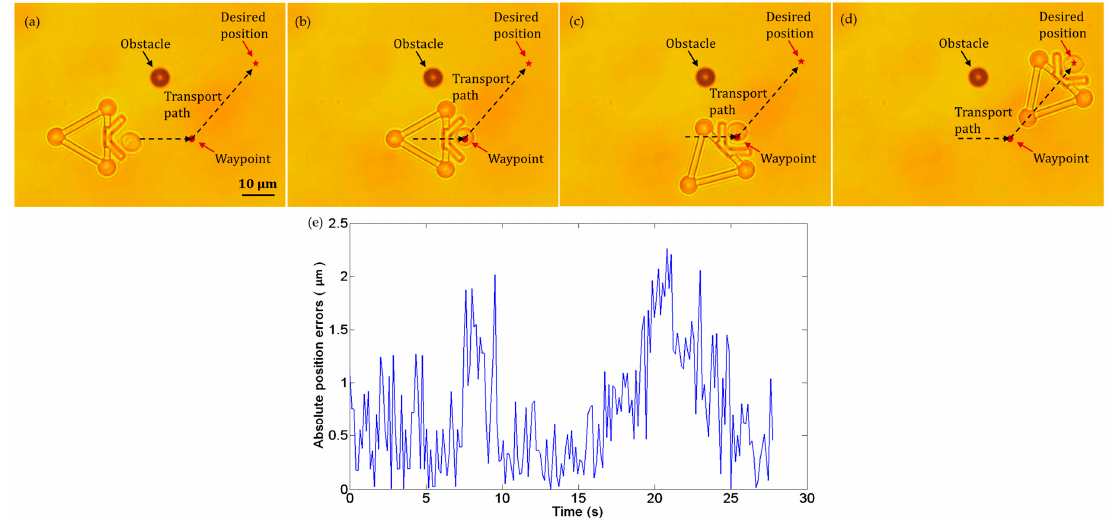
Figure 12. Experiments of cell transport with an obstacle in the workspace. ( a ) t = 0 s: the cell in the initial position. ( b ) t = 8 s: the cell reached the waypoint in the path. ( c ) t = 17 s: the microtool was turned to the new direction. ( d ) t = 28 s: the cell was successfully transported to the desired position. ( e ) Absolute position errors of the cell in transport.